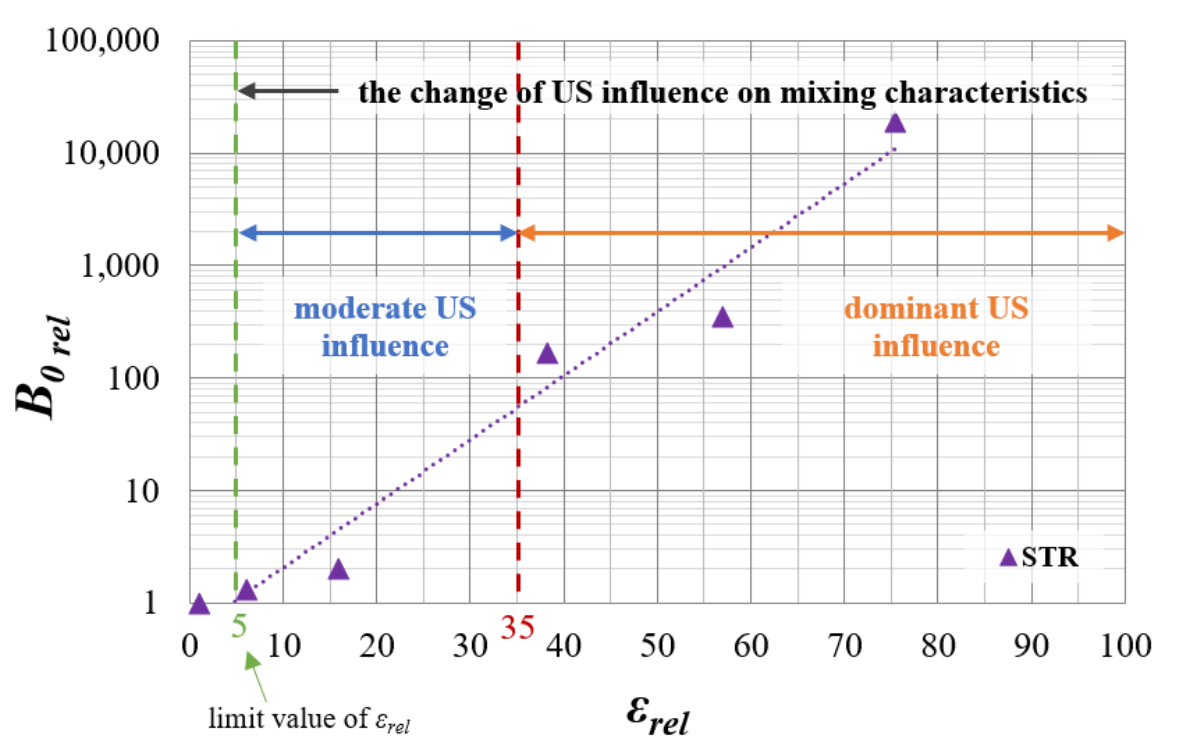
Figure 3. The relative nucleation intensity B 0 rel as a function of the relative input power ε rel in the STR.